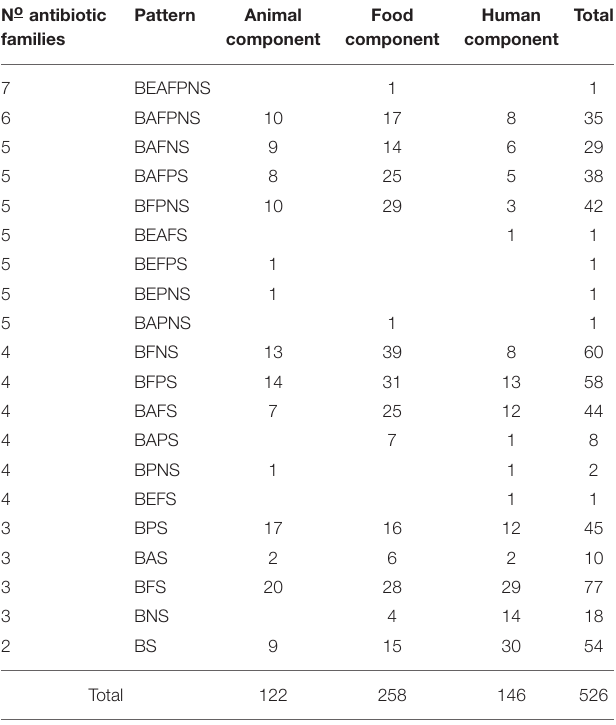
TABLE 2 | Antimicrobial resistance patterns by antibiotic